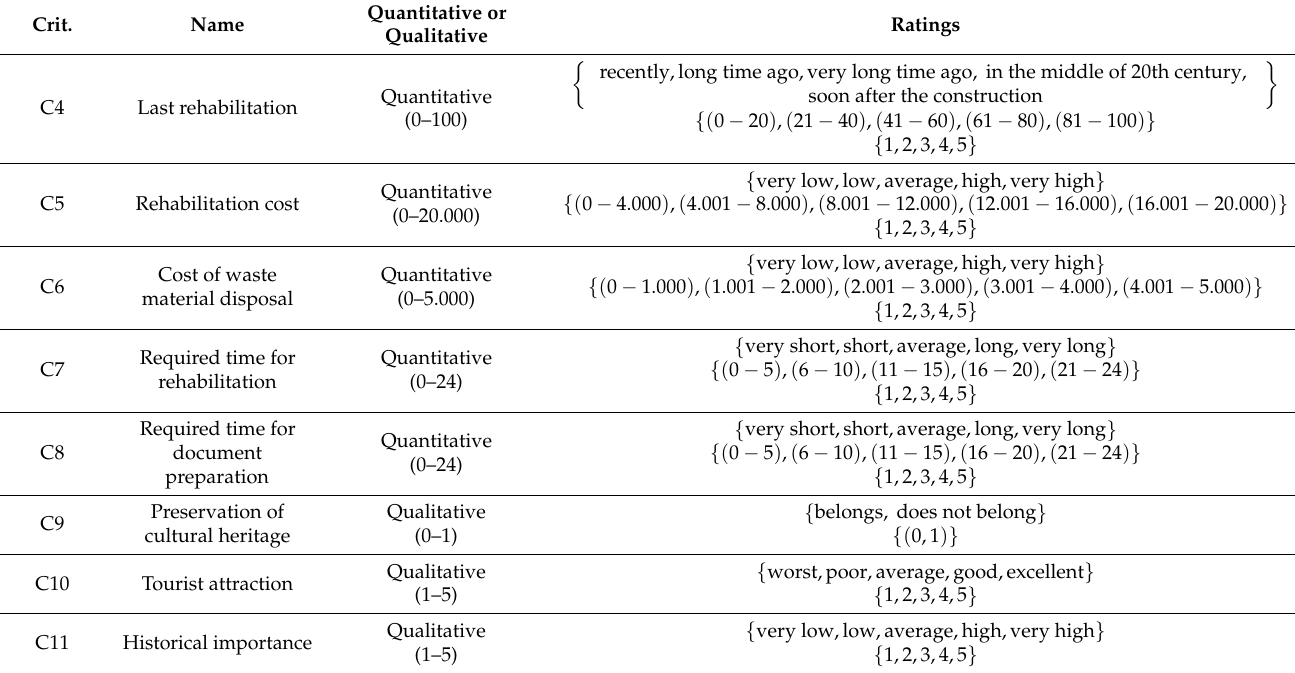
Figure 5. Ri č evica, Kaštel Štafili ć (B2).